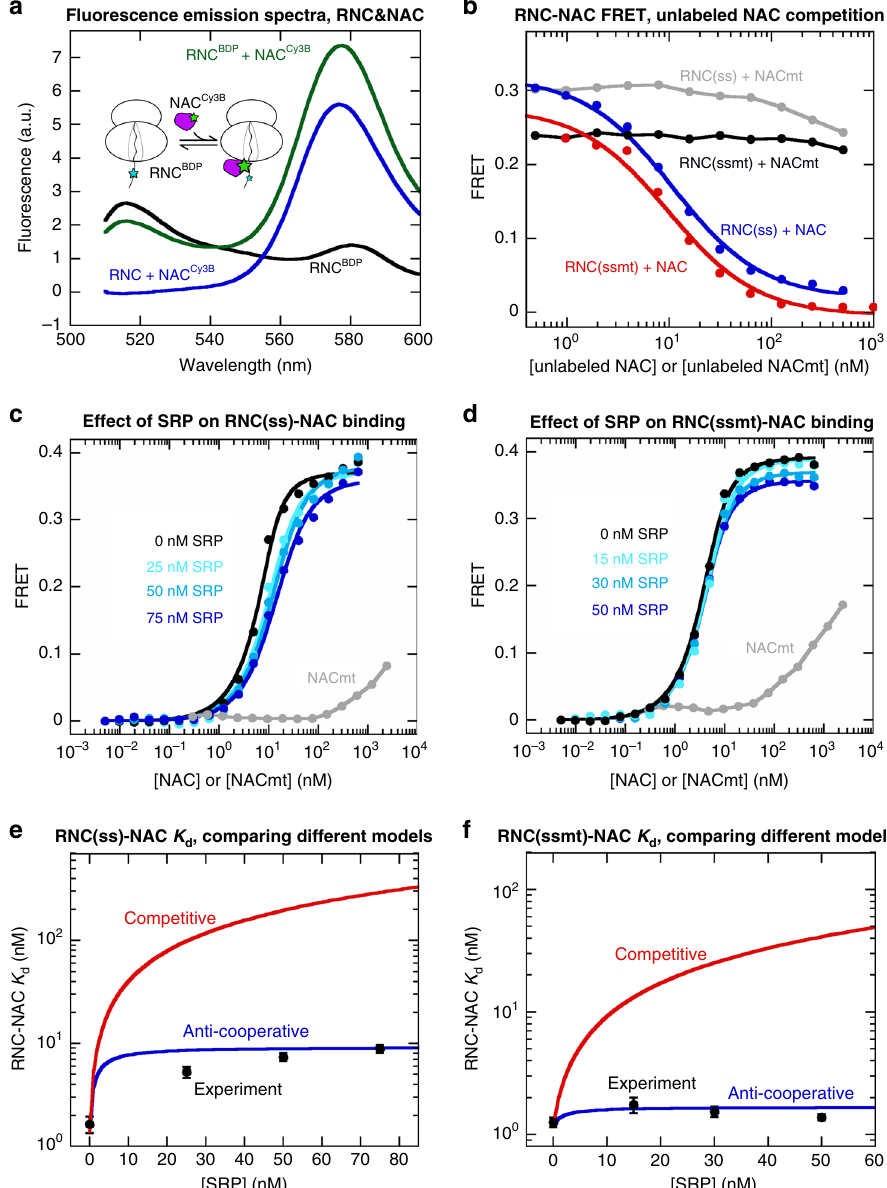
Fig. 4 An RNC-NAC binding assay shows co-binding of SRP and NAC on the RNC. a Inset: scheme of the FRET assay to measure RNC-NAC binding. RNC was labeled with BDP (cyan star) at the N-terminus of signal sequence, and NAC was labeled with Cy3B (green star) at residue 57 of NAC β . Figure: Fluorescence emission spectra showing FRET between labeled RNC and NAC. Where indicated, the reactions contained 1 nM RNC(ss) BDP or 15 nM unlabeled RNC(ss) and 5 nM NAC Cy3B . The spectra were measured by excitation at 485 nm. b Competition assay to determine the RNC binding af fi nity of unlabeled NAC and NACmt. 1 nM RNC BDP and 20 nM NAC Cy3B were pre-incubated to form the RNC BDP -NAC Cy3B complex, followed by addition of unlabeled NAC or NACmt to compete with NAC Cy3B for RNC binding. The data with NAC were fi t to Eq. (6) in the Methods, which gave K d values of 0.55 and 0.50 nM for the binding of unlabeled NAC to RNC(ss) and RNC(ssmt), respectively. c , d Equilibrium titrations to measure the binding of NAC to RNC (ss) ( c ) and RNC(ssmt) ( d ) in the presence of increasing SRP concentrations. The reactions contained 5 nM RNC BDP and the indicated concentrations of NAC Cy3B , unlabeled NAC and SRP. The data were fi t to Eq. (5) to obtain apparent K d,NAC values at the individual SRP concentrations. e , f Comparison of the experimentally determined apparent K d,NAC values at different SRP concentrations (black squares) with predictions from the anti-cooperative model in Fig. 3g (blue line, simulated using Eq. (10)) and the competitive model in Supplementary Fig. 4a (red line, simulated using Eq. (11)). The simulations in e used K d,SRP , K d,NAC and α values of 0.36 nM, 1.4 nM, and 6.6, respectively. The simulations in f used K d,SRP , K d,NAC and α values of 1.5 nM, 1.2 nM, and 1.4, respectively. The experimental data were shown as mean ± SD, with n = 3 independent measurements on the same biological sample. Source data for a – f are provided in the Source Data fi RNC (cid:129) NAC in the SRP-SR association measurements in Fig. 2. than with RNC(ss). Thus, the observed effects of NAC on SRP-SR Further, the smaller anti-cooperativity between SRP and NAC for association (Fig. 2d – g) cannot be attributed to the exclusion of SRP binding RNC(ssmt) compared to RNC(ss) is contrary to the larger from the RNC and must instead arise from NAC-induced allosteric inhibitory effect of NAC on SRP-SR association with RNC(ssmt) regulation of SRP in a ternary RNC-SRP-NAC complex.